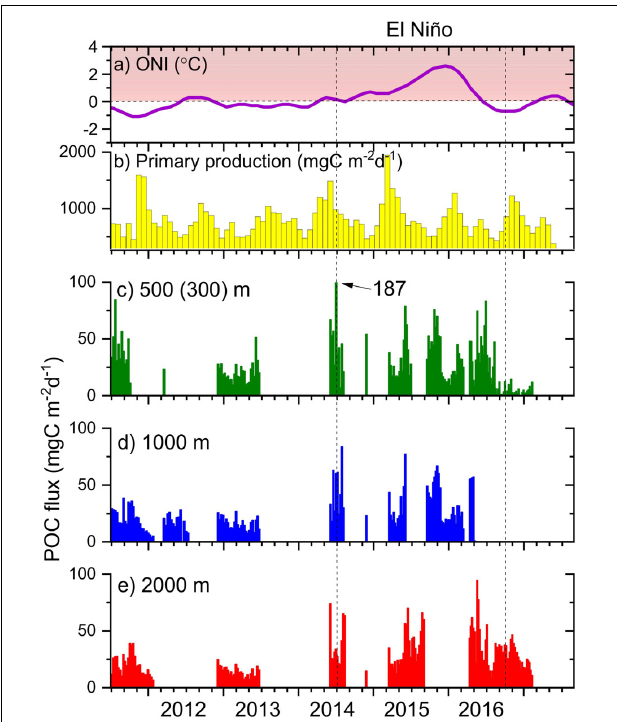
FIGURE 3 | (a) ONI (Oceanic Nino Index; upper panel); (b) net primary production determined from MODIS-aqua satellite observations and the Vertically Generalized Productivity Model (middle panel); and (c–e) the POC flux at 500 m, 1000 m, and 2000 m, respectively. Where there is no bar, there were no data.